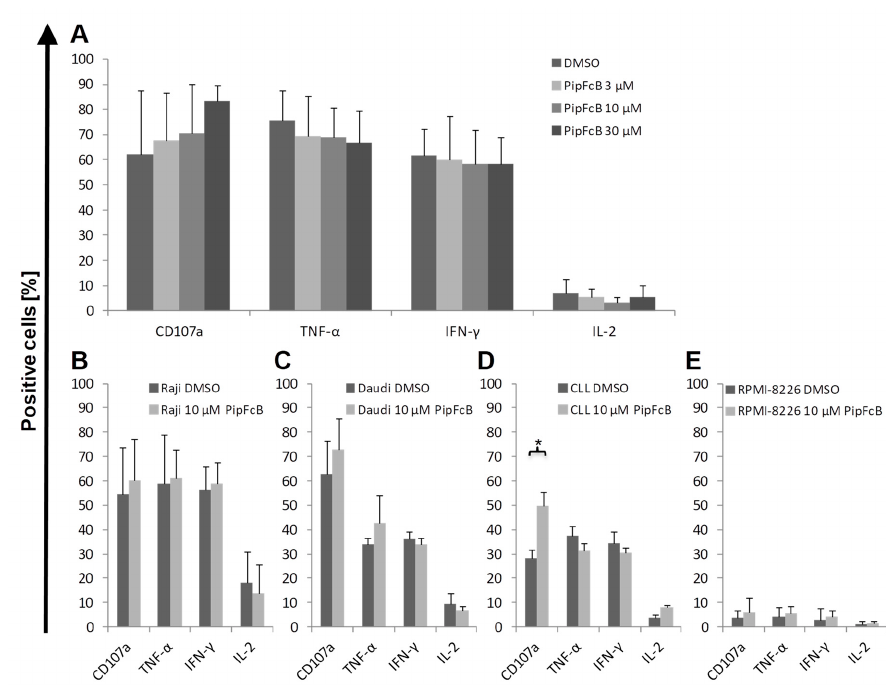
Figure 6. Influence of PipFcB on CART degranulation and intracellular cytokine production. CARTs were co-cultured for 6 h with Raji cells in the presence of PipFcB in di ff erent concentrations (3 µ m, 10 µ m, 30 µ M). DMSO served as solvent control ( A ). Experiments were performed in three independent experiments. No di ff erences in CD107a expression and intracellular production of TNF- α , IFN- γ and IL-2 was observed in the cultures supplemented with PipFcB, compared to the solvent control. 10 µ M of PipFcB was further evaluated with CART stimulation by Raji ( n = 6; B ), Daudi ( n = 3; C ), primary CLL ( n = 3; D ), and RPMI-8226 cells ( n = 3; E ). No di ff erences in CD107a expression and intracellular production of TNF- α , IFN- γ and IL-2 were observed in Raji-, Daudi-, or RPMI-8226-stimulated CART cultures supplemented with PipFcB, compared to the solvent control. The only significant di ff erence by PipFcB was observed for CD107a expression on CARTs stimulated with primary CLL cells. Mean values were calculated for each group; error bars indicate standard deviation (* p < 0.05). Int. J. Mol. Sci. 2019 , 20 FOR PEER REVIEW